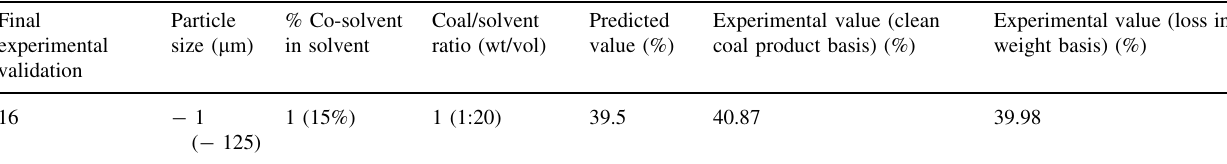
Table 9 Final validation for maximum extraction yield Final experimental